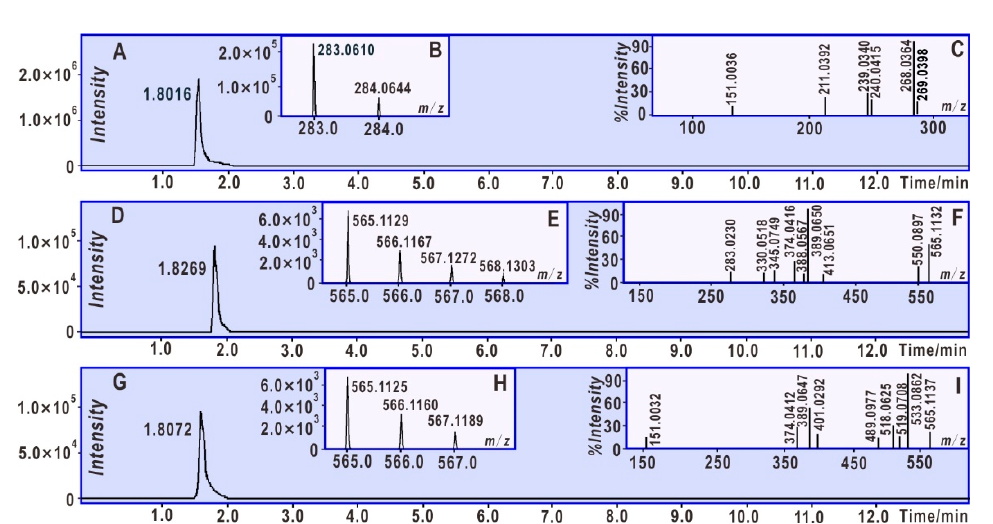
Figure 2. Main results of the ultra ‐ performance liquid chromatography coupled with electrospray ionization quadrupole time ‐ of ‐ flight tandem mass spectrometry (UHPLC − ESI − Q − TOF − MS) analysis of acacetin and isoginkgetin mixed with 4 ‐ methoxy ‐ TEMPO radicals (negative ion model). ( A ) Chromatographic peaks of acacetin when the formula [C 16 H 12 O 5 ‐ H] − was extracted; ( B ) MS spectra of acacetin; ( C ) MS/MS spectra of acacetin (from the precursor m / z 283.0610); ( D ) chromatographic peaks of dimeric acacetin when the formula [C 32 H 22 O 10 ‐ H] − was extracted; ( E ) MS spectra of dimeric acacetin; ( F ) MS/MS spectra of dimeric acacetin (from the precursor m / z 565.1129); ( G ) chromatographic peaks of authentic isoginkgetin when the formula [C 32 H 22 O 10 ‐ H] − was extracted; ( H ) MS spectra of authentic isoginkgetin; and ( I ) MS/MS spectra of authentic isoginkgetin (from the precursor m / z 565.1125).